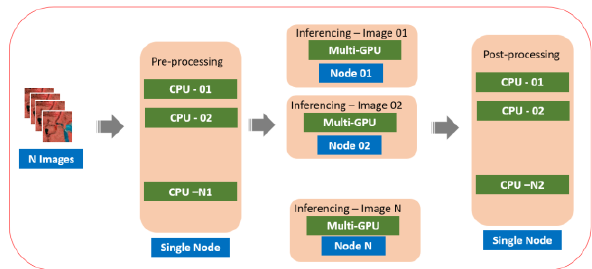
Figure 8. A semantic diagram of multi-CPU-GPU MAPLE workflow model using multiple HPC nodes.